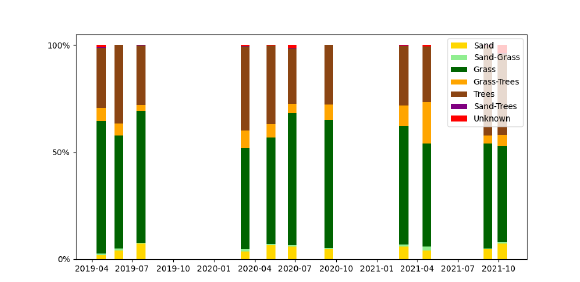
Figure 6. Percentage of pixels per pure and fuzzy class for each of the 11 Neural Network classifications of individual Superview-1 images enriched by AHN4